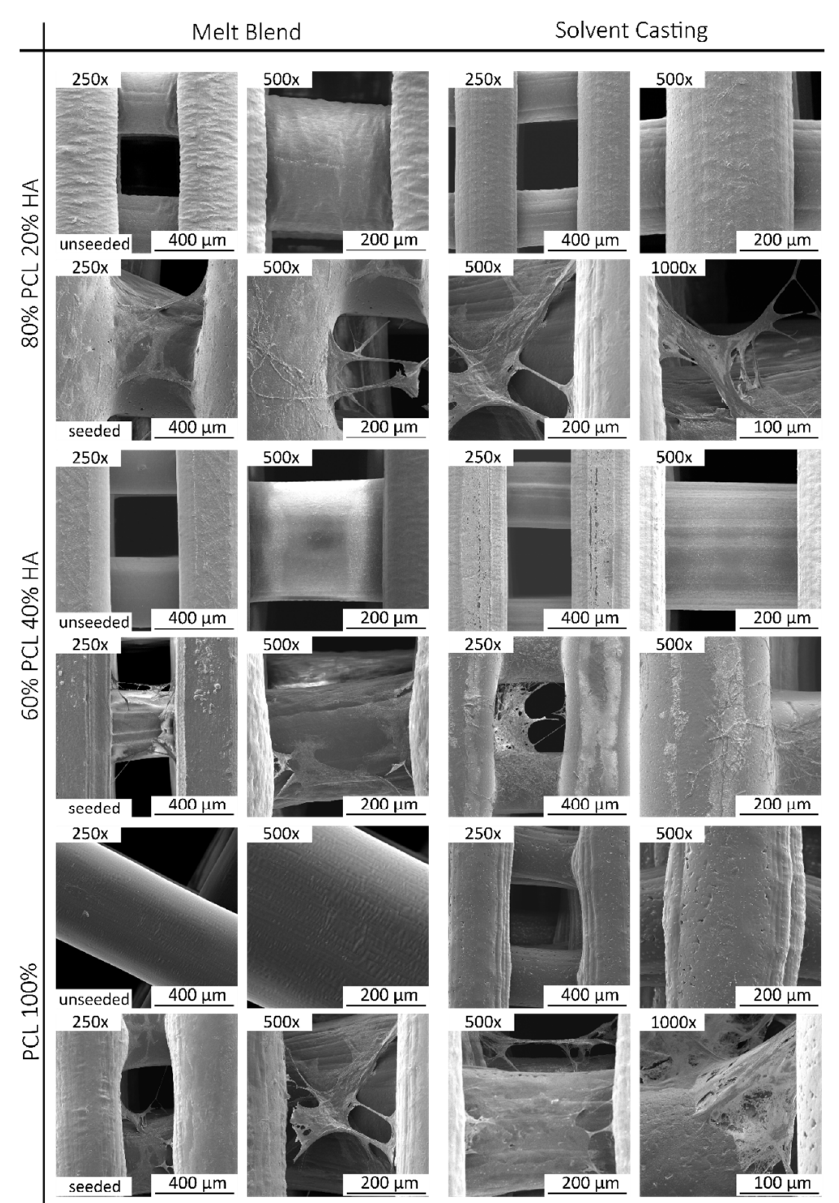
Figure 10. SEM analyses of the seeded and unseeded scaffolds with different magnifications. Images obtained by a high resolution (Schottky) Environmental Scanning Electron Microscope with X-ray microanalysis and Electron Backscattered Diffraction analysis: Quanta 400 FEG ESEM/EDAX Genesis X4M in high vacuum mode.